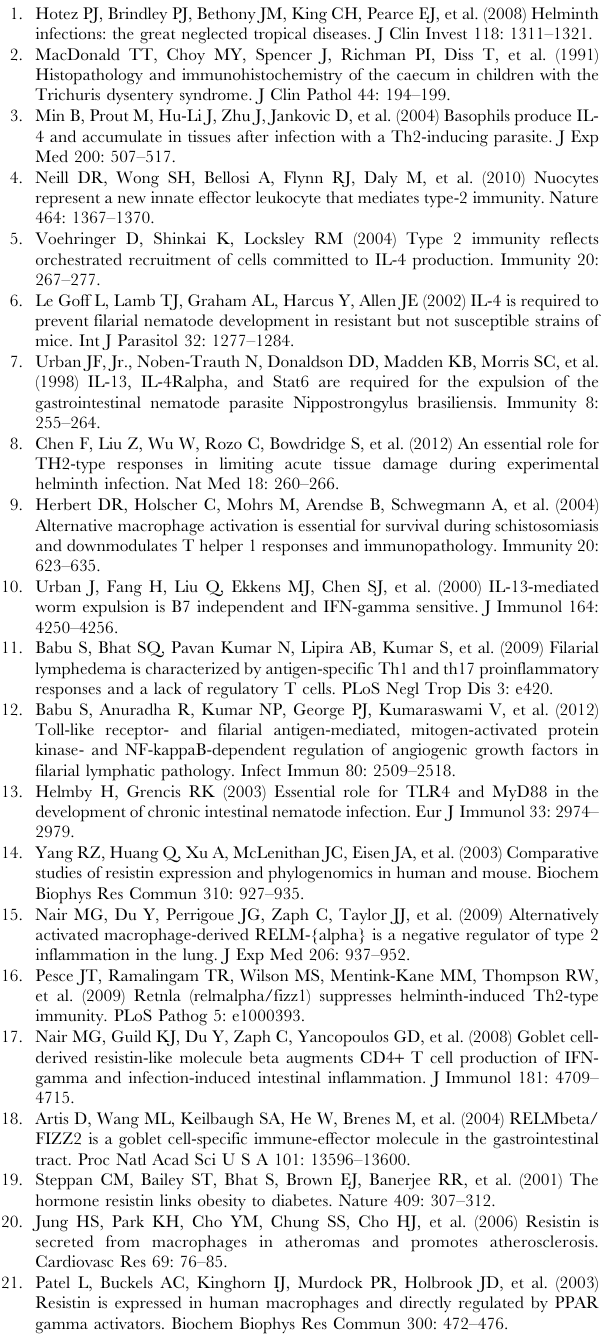
S2 Table Cell composition in the peritoneal cavity following recombinant hResistin injection. S3 Table Type 2 immunity is not altered by resistin in filarial-infected